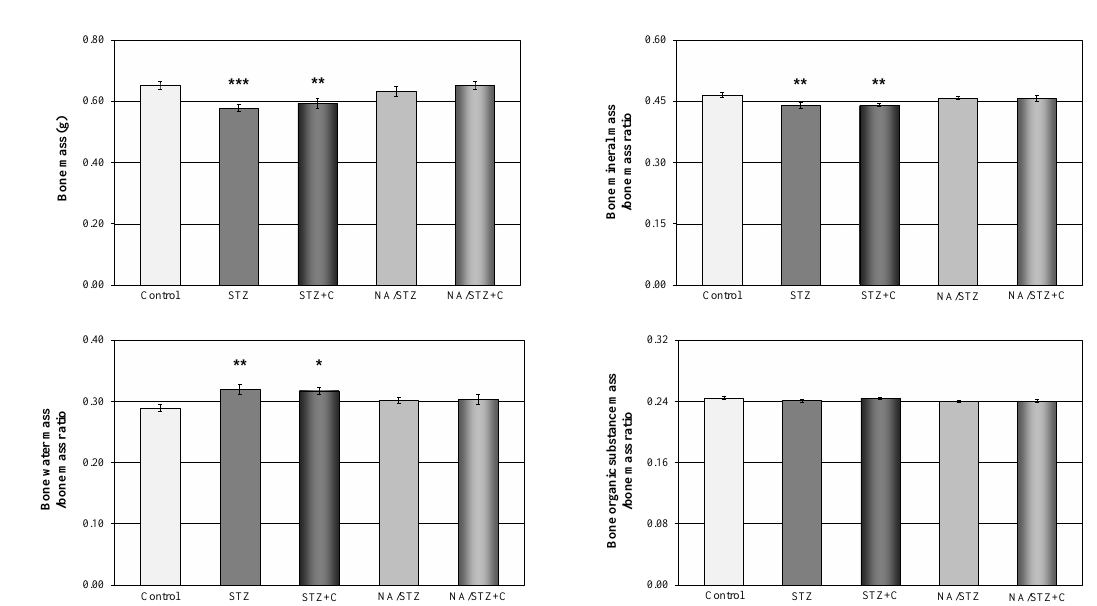
Figure 2. Effect of caffeine administered orally (C; 20 mg/kg daily for four weeks) on mass and composition of the femur in rats treated with streptozotocin (STZ) or nicotinamide and streptozotocin (NA/STZ). Results are presented as means ± SEM (standard error of the mean; n = 8–10).